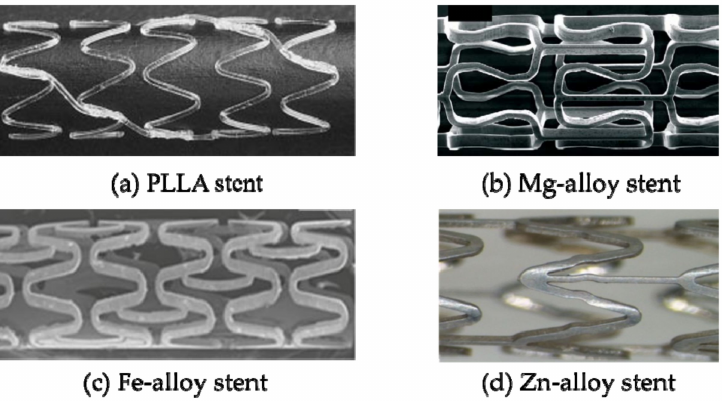
Figure 5. BDSs: ( a ) PLLA stent [52]; ( b ) Mg-allot stent [53]; ( c ) Fe-alloy stent [54]; ( d ) Zn-alloy stent [55].